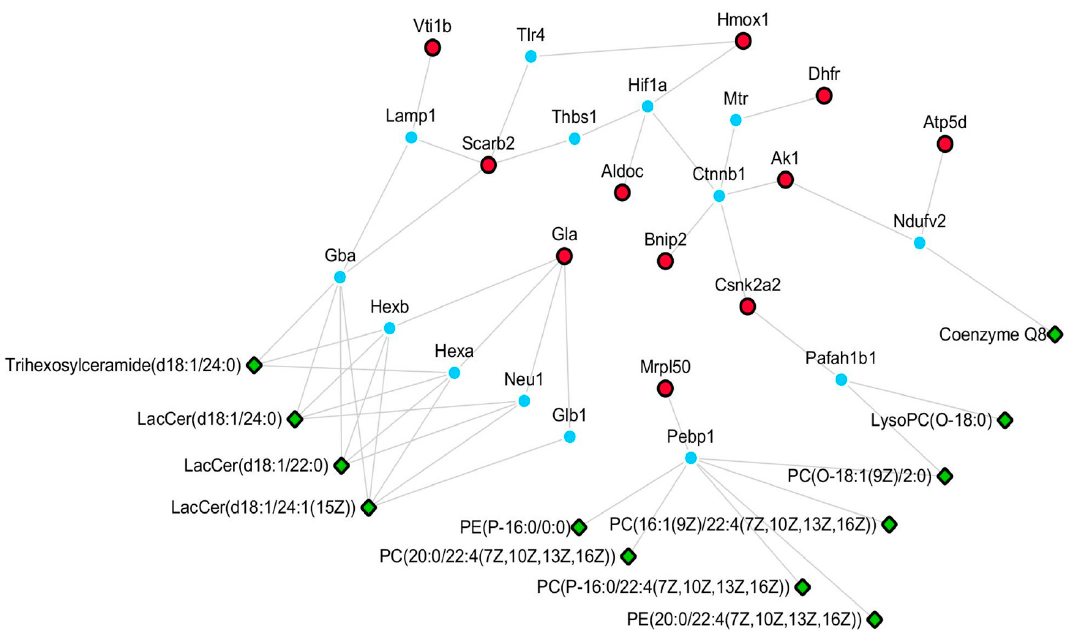
Figure 6. Network of differentially-expressed proteins and lipids. Green part: differentially-expressed lipids of lipidomics study; Red part: differentially-expressed proteins of proteomics; Blue part: upstream proteins of metabolites.